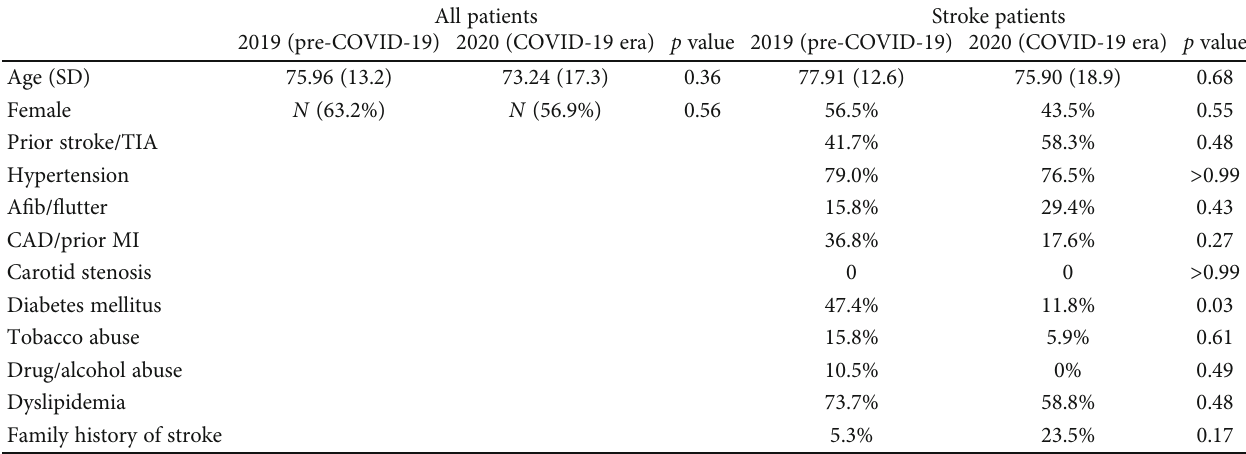
Table 1: Demographics of all patients and patients with a fi nal diagnosis of stroke. All patients